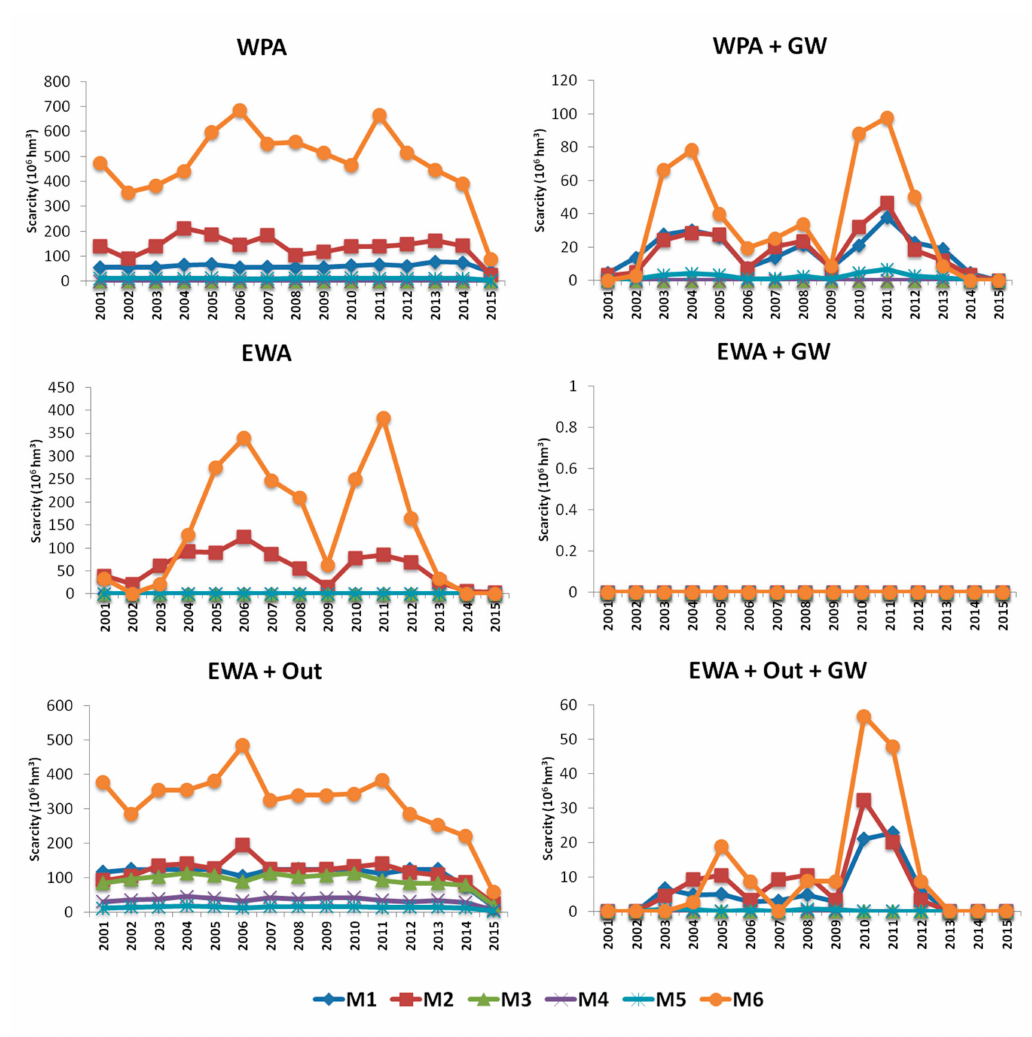
Figure 7. Scarcity (10 6 m 3 ) on the six regions in each simulated scenario